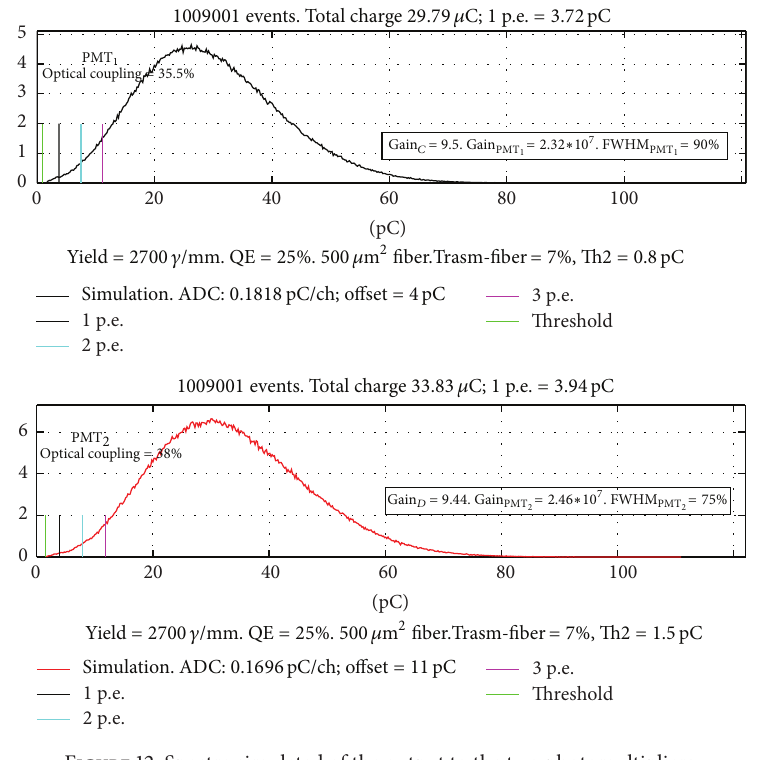
Figure 12: Spectra simulated of the output to the two photomultipliers.